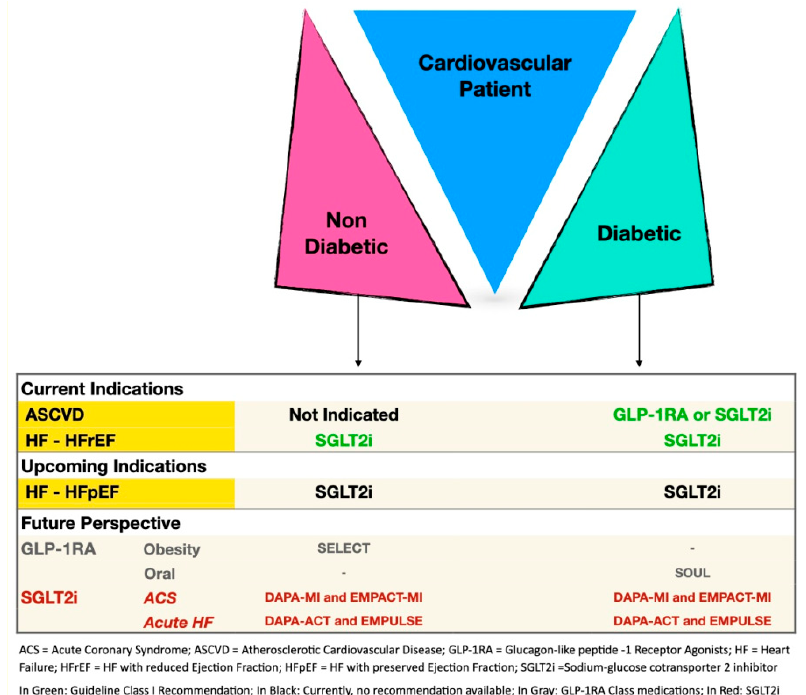
Table 3 Legend: HFrEF: Heart failure with reduced ejection fraction; HFpEF: Heart failure with preserved ejection fraction. & The primary outcome was a composite of adjudicated cardiovascular death or hospitalization for heart failure. * The primary end- point was the composite of worsening heart failure (hospitalization or an urgent visit resulting in intravenous therapy for heart failure) or death from cardiovascular causes. $